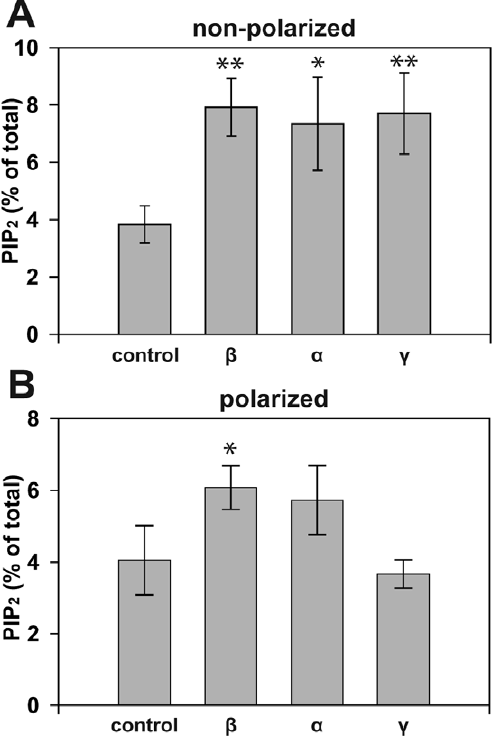
Figure 4. Effect of PIP5KI overexpression on PtdIns(4,5)P 2 levels in renal epithelial cells. Non-polarized (A) or polarized (B) mCCD cells infected with either control adenovirus or virus encoding PIP5KI b , PIP5KI a , or PIP5KI c were radiolabeled with 32 P i for 4 h then acidic lipids collected and analyzed by TLC. PtdIns(4,5)P 2 was quantified as the percent of total acidic phospholipids recovered in each sample. Each graph represents the mean + / 2 SE of at least four experiments performed in duplicate. One way ANOVA with Bonferroni correction was performed to determine statistical significance (**p , 0.01 *p , 0.05). Whereas expression of each isoform increased cellular PtdIns(4,5)P 2 levels in non-polarized cells, only PIP5KI b had a significant effect on PtdIns(4,5)P 2 in polarized cells.